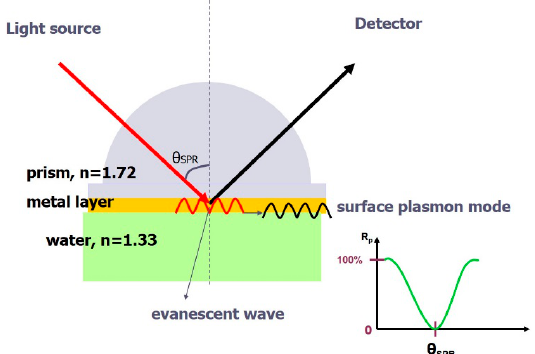
Figure 3. A prism-based SPR sensor with a gold film as sensing layer. The light is absorbed by surface plasmons at a particular resonant angle.